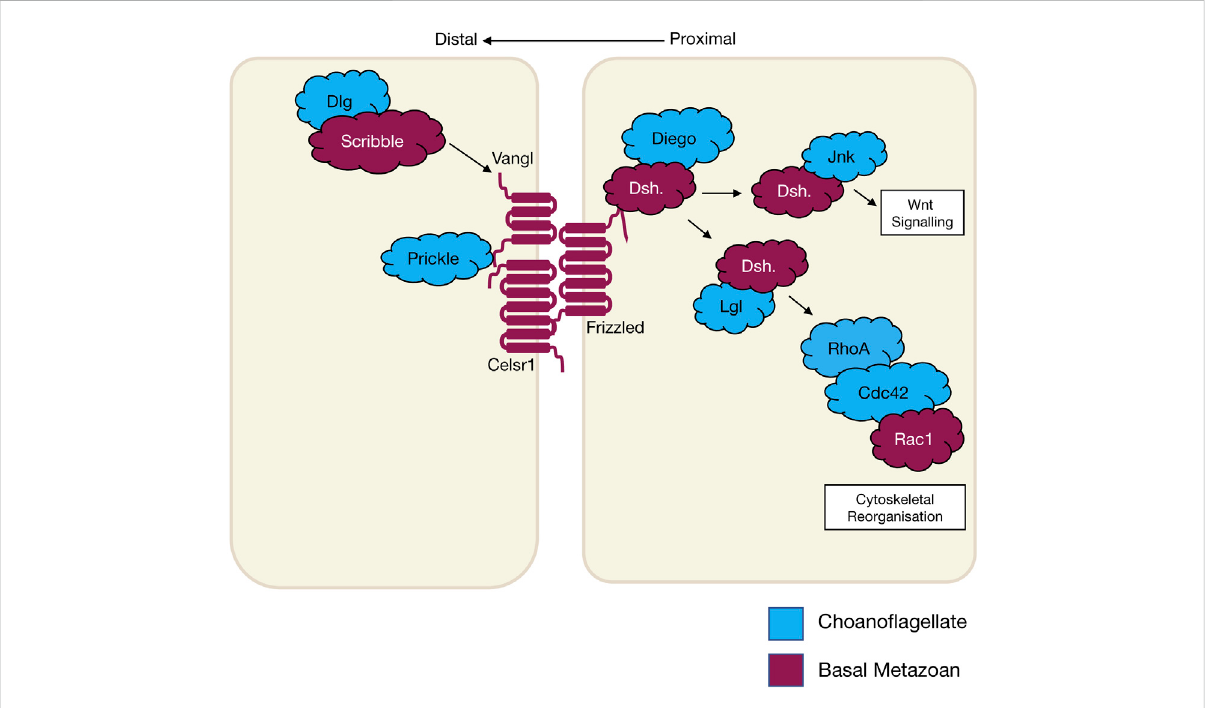
FIGURE 3 The schematic diagram shows core planar cell polarity pathways and their relationship to Wnt signalling and cytoskeletal reorganisation that occurs in wound healing. The different colours represent the evolutionary appearance of these